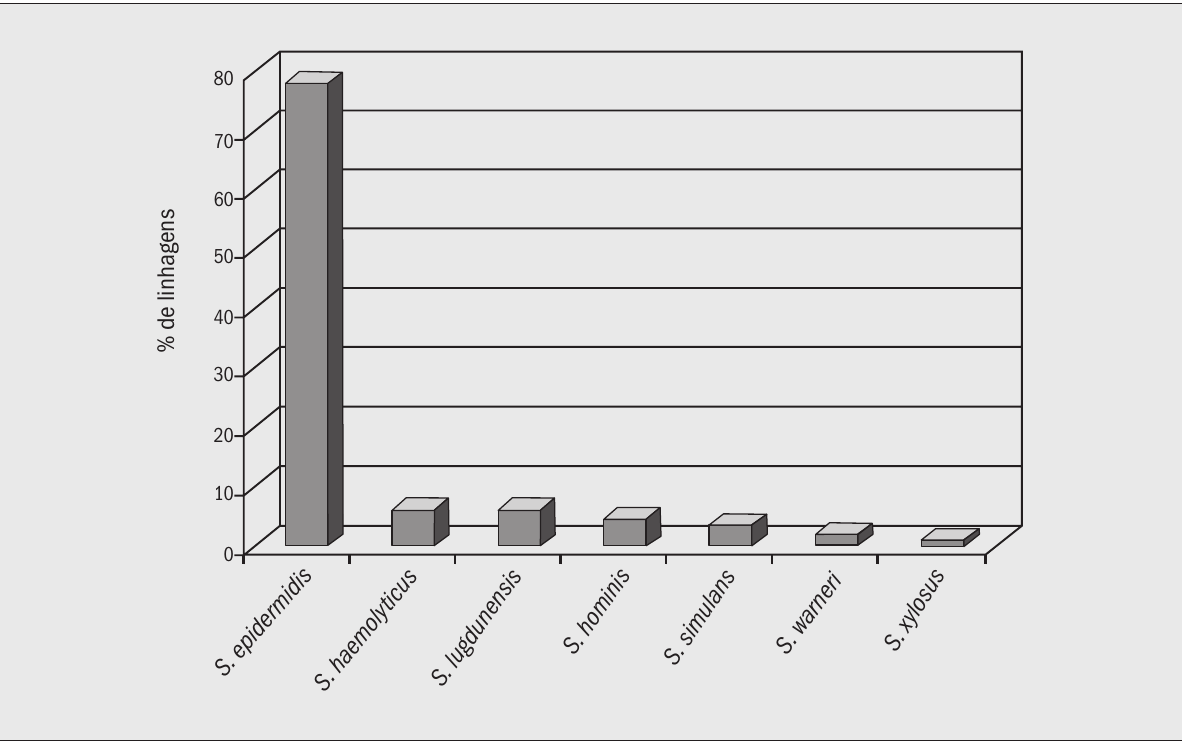
Figura 1 – Distribuição das espécies de ECN isoladas de recém-nascidos